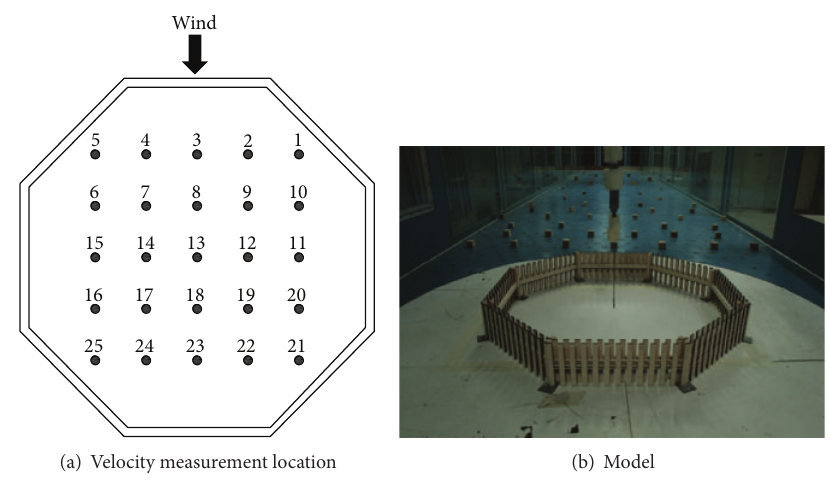
Figure 15: Wind velocity measurement locations and CASE 1 model installed in the wind